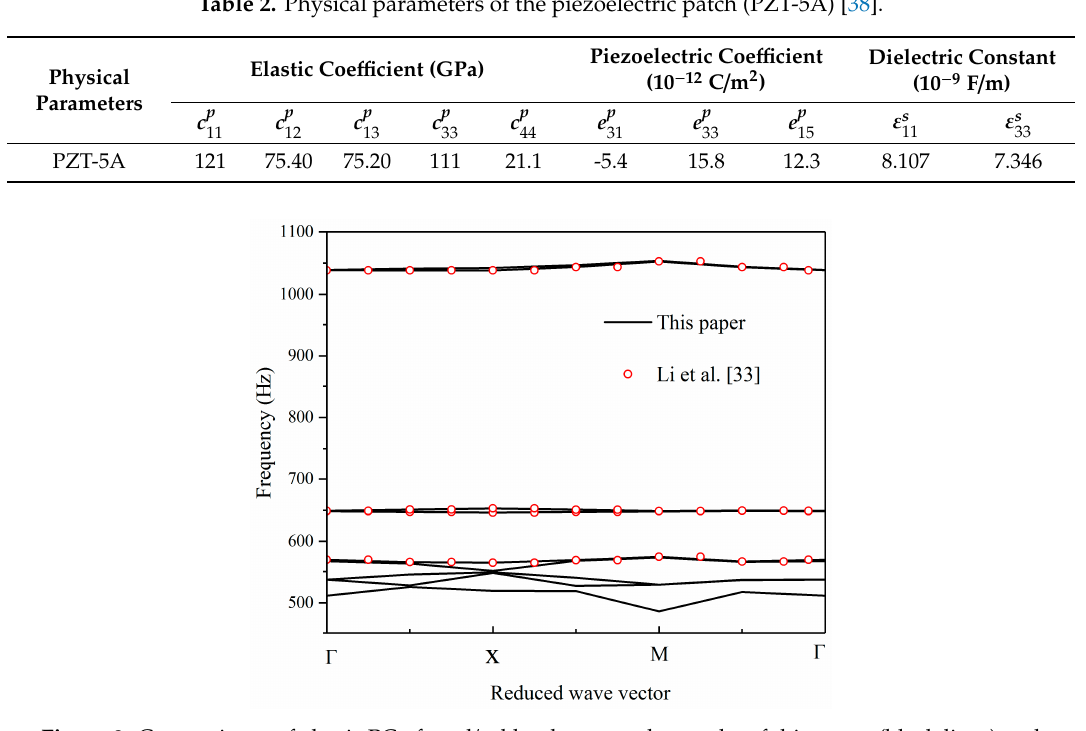
Figure 3. Comparisons of elastic PC of steel / rubber between the results of this paper (black lines) and those of Ref. [35] (red dots).